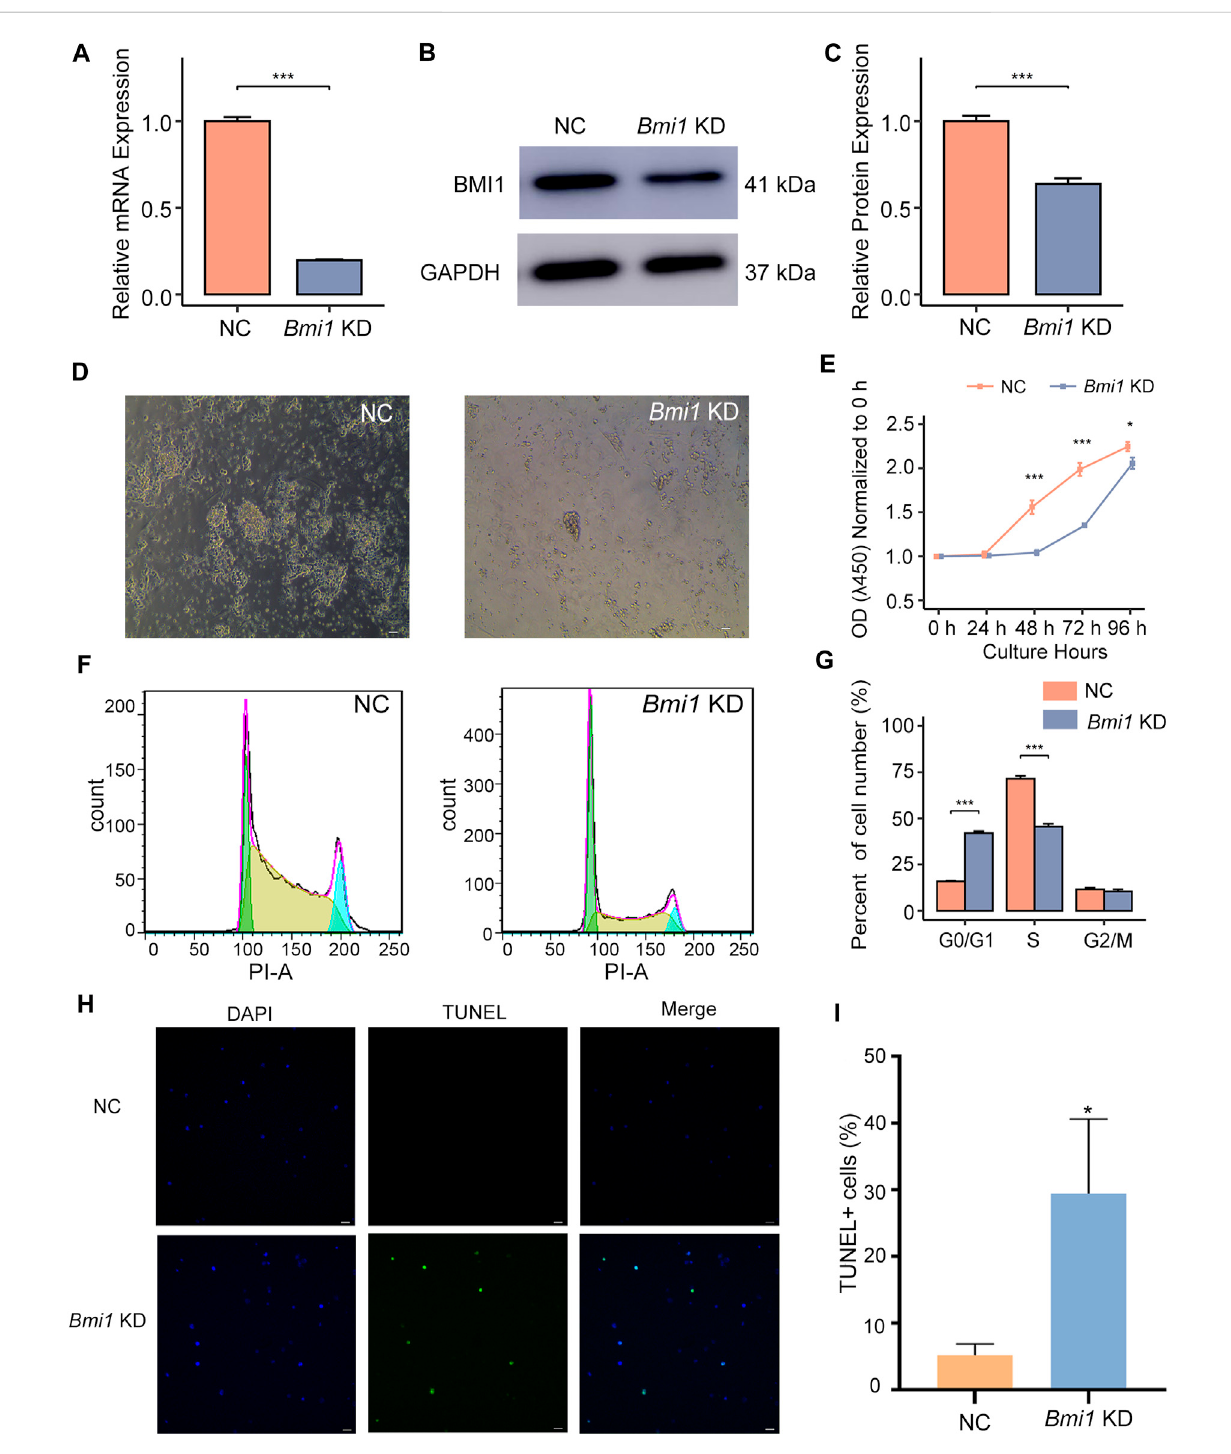
FIGURE 1 Bmi1 knockdown disturbs undifferentiated spermatogonia maintenance. (A) qPCR analysis of Bmi1 mRNA expression in control (NC) and Bmi1 knockdown cells (KD) 2 days after transfection. Data are showed as means ± s.d. and derived from three independent experiments. (B) Western blotting analysis of BMI1 expression in NC and Bmi1 KD cells 2 days after transfection. (C) The protein expression levels of BMI1 are measured by Image J analysis. (D) Representative images of NC and Bmi1 KD cells 2 days after transfection. Scale bar, 20 μ m. (E) CCK-8 assay of undifferentiated spermatogonia treatedwith Bmi1 siRNAorNCsiRNAfor4 days. (F) Cellcycledistributionisdetermined by fl owcytometry. (G) TheproportionofcellnumberinG0/G1, S and G2/M state is determined by fl ow cytometric analysis. (H) TUNEL staining of NC and Bmi1 KD cells 2 days after transfection. Scale bar, 20 μ m. (I) Quanti fi cation of TUNEL + cells. Data are showed as means ± s.d. and derived from three independent